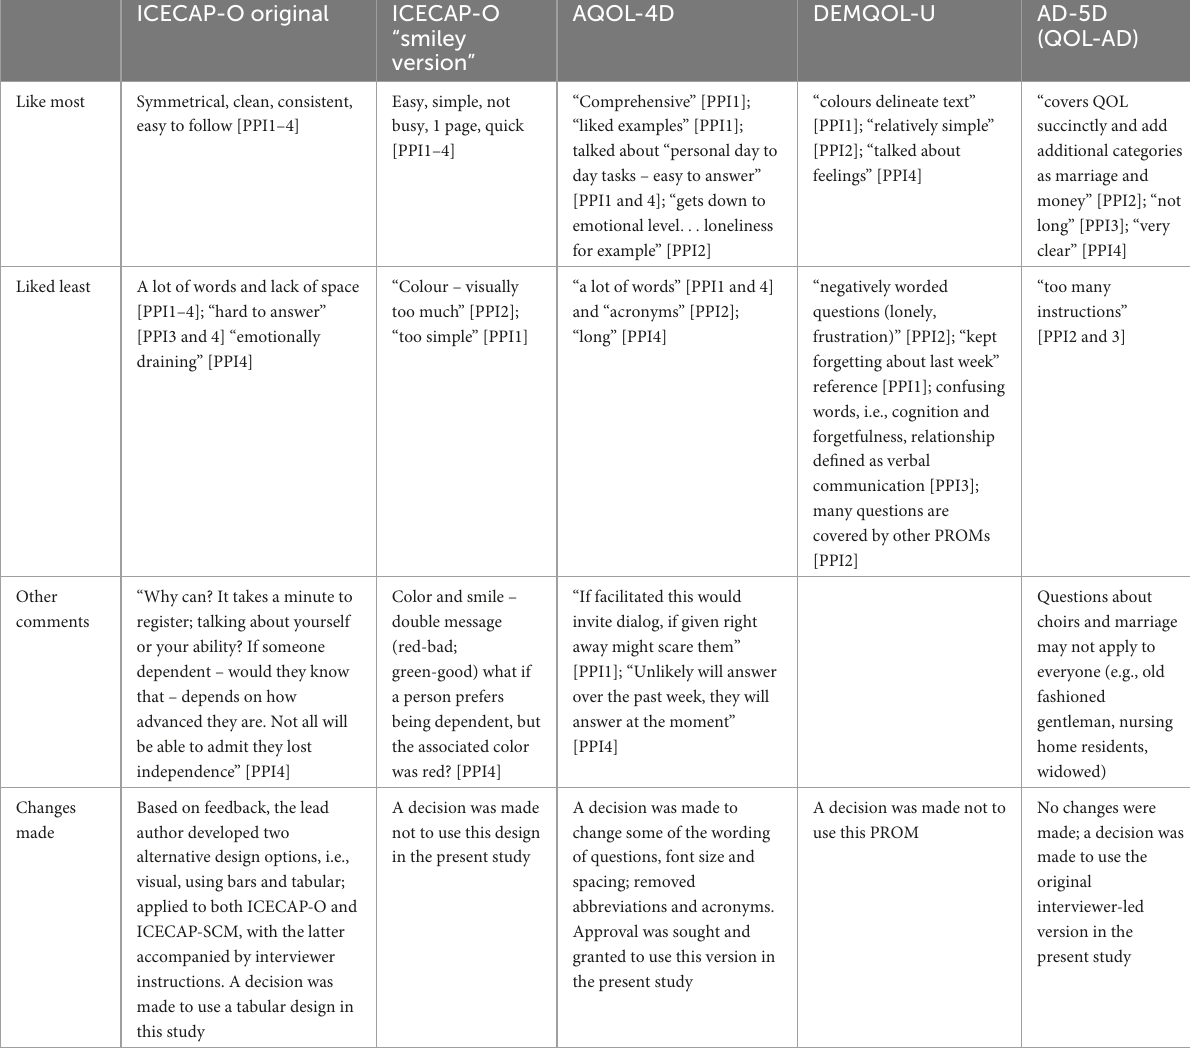
TABLE 1 Synopsis of the PPI/PPV feedback received and corresponding changes